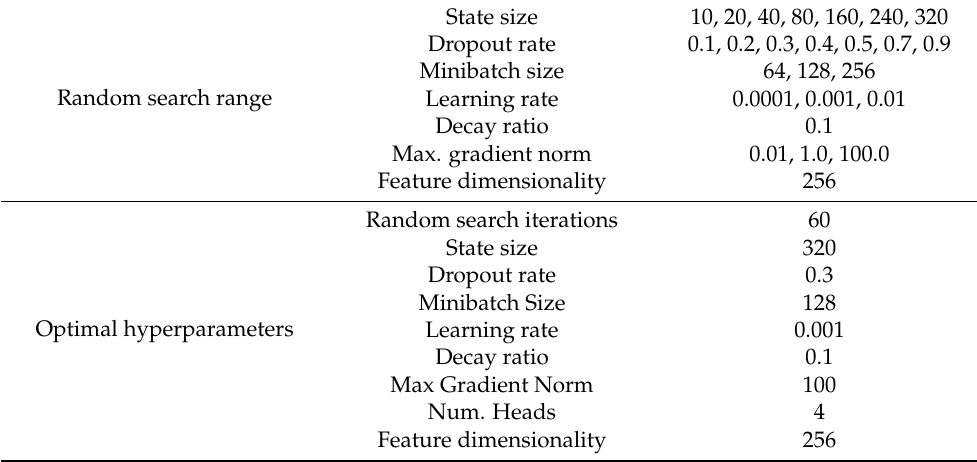
Table 5. Hyperparameter